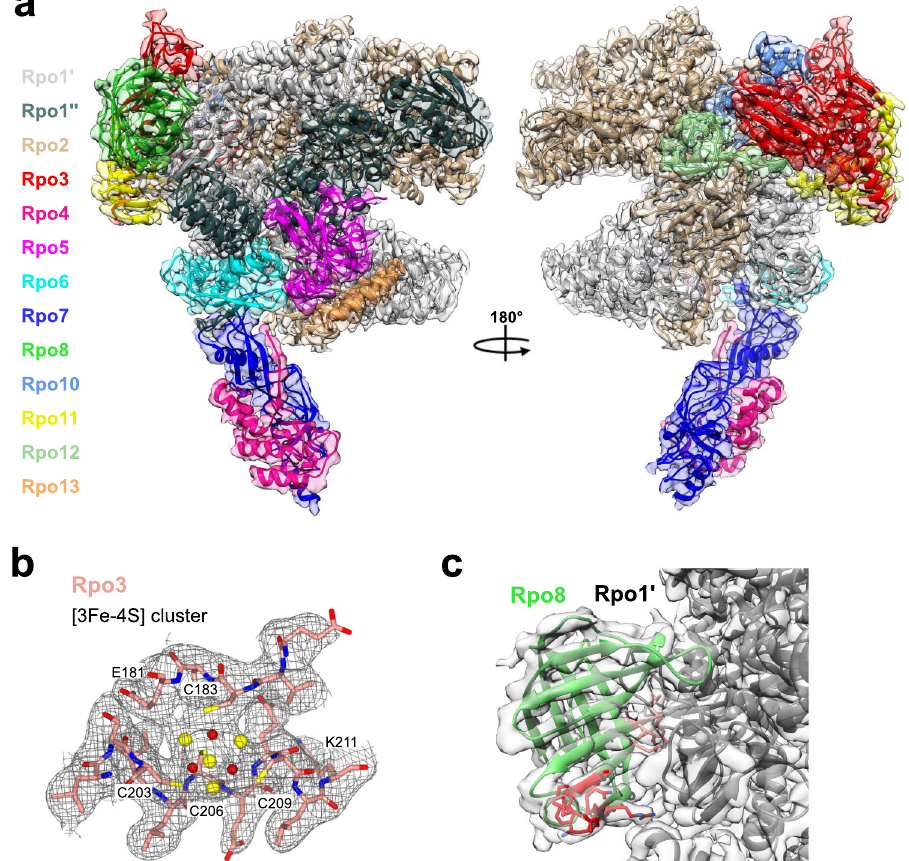
Fig. 1 The complete structure of the crenarchaeal RNA polymerase. a Cryo-EM map and cartoon representation of Sulfolobus acidocaldarius RNA polymerase. This composite map is illustrated as semi-trasparent surface and obtained by merging the cryo-EM map of apo-RNA polymerase with the stalk resulting from the multi-body re fi nement of the TFS4-bound RNA polymerase. Each subunit is highlighted according to the colour code shown on the left, the cryo-EM map is illustrated as semi-transparent surface. b Details of the apo-RNAP map showing the coordination system of the [3Fe-4S] cluster with sulphur atoms in yellow spheres and iron in dark red. Rpo3 residues are shown as sticks in red as in a , while the map is shown in mesh. c Cartoon representation of Rpo8 bound to Rpo1´ within the cryo-em map shown here in semi-transparency. The β 5 – 6 loop is highlighted in red, and the conserved GGLLM motif in orange. The corresponding sequence alignment is reported in Supplementary Fig.